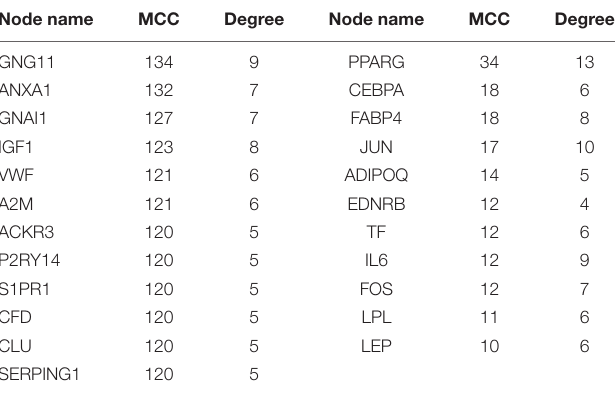
volcano plot, red and green points are the differential genes. They were screened out based on |logFC| ≥ 1.0 and (adjusted P ) < 0.05.